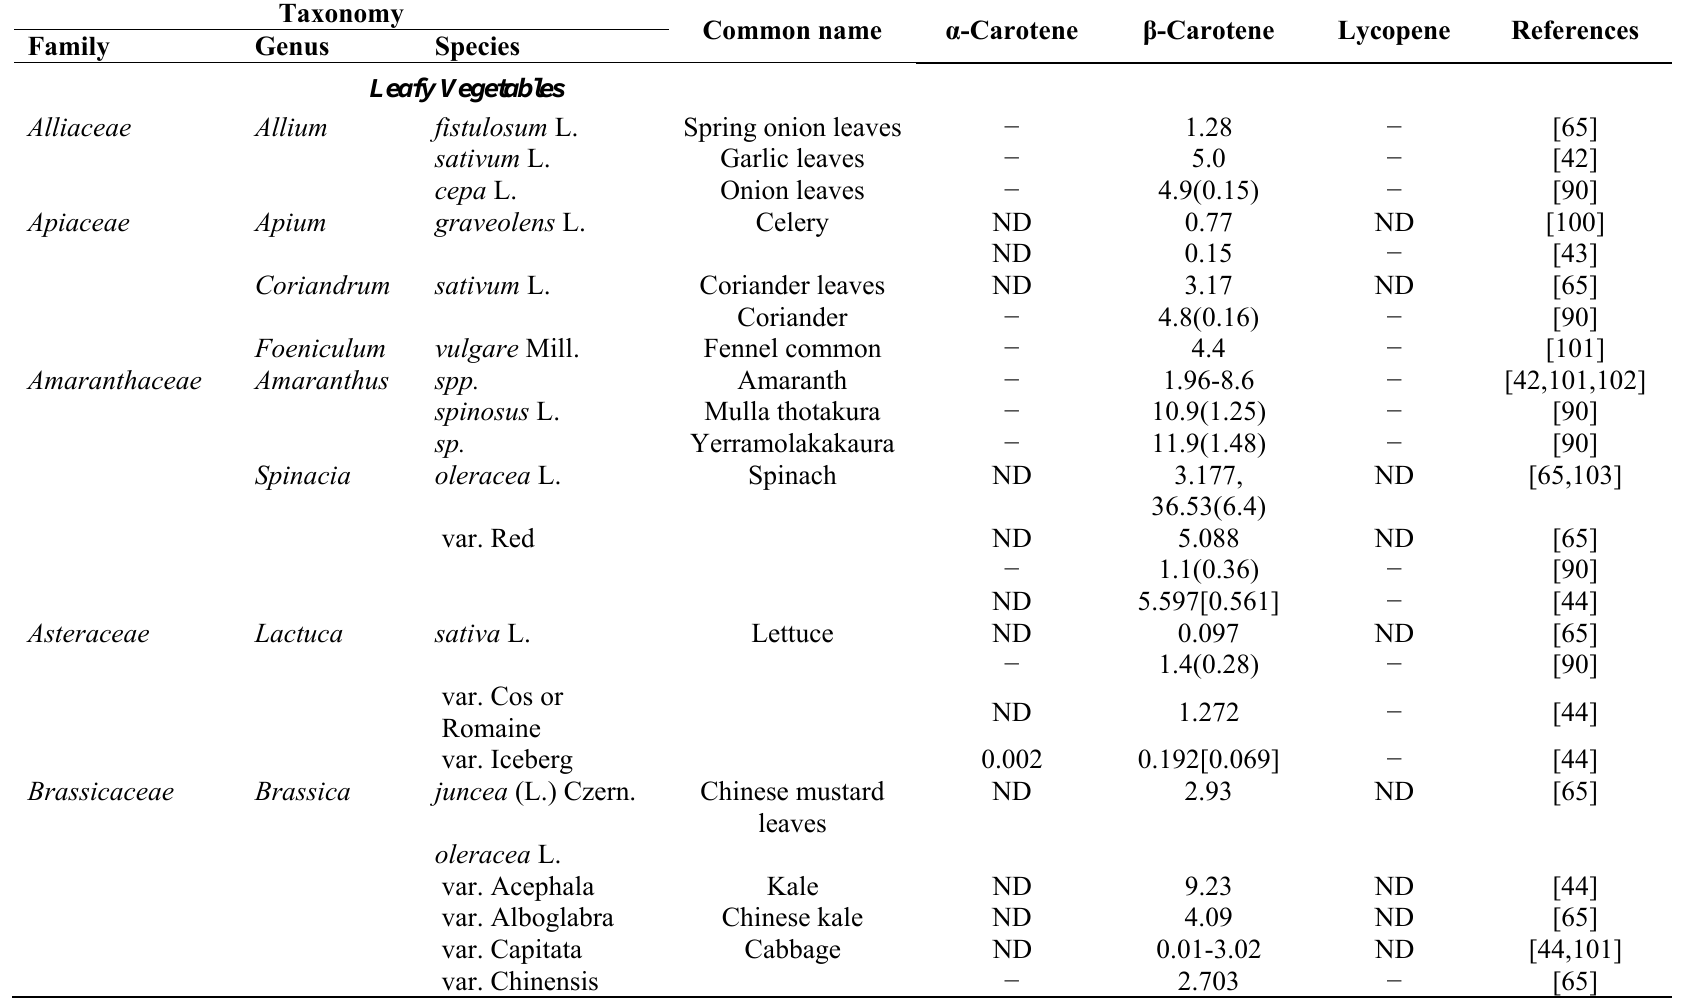
Table 3. Carotenoid contents (mg/100 g fresh weight) of common leafy and non-leafy